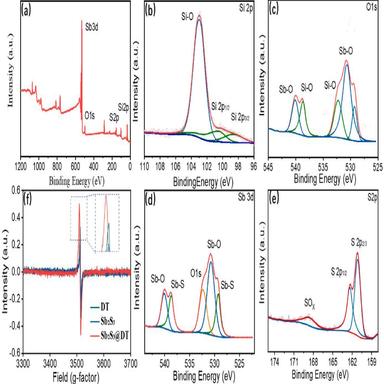
XPS analysis of Sb2S3@DT: full XPS spectra (a), Si 2p spectra (b), O1 s spectra (c), Sb 3d spectra (d) and S 2p spectra (e). EPR spectra (f) of Sb2S3@DT